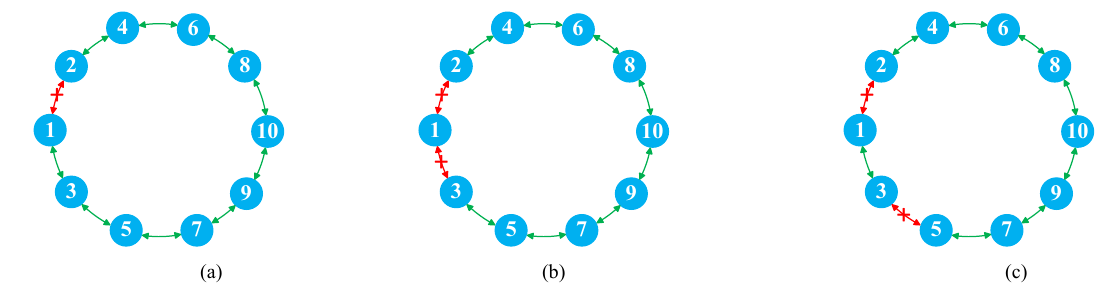
Figure 13. Control input with ETCP with time delay 80 ms .